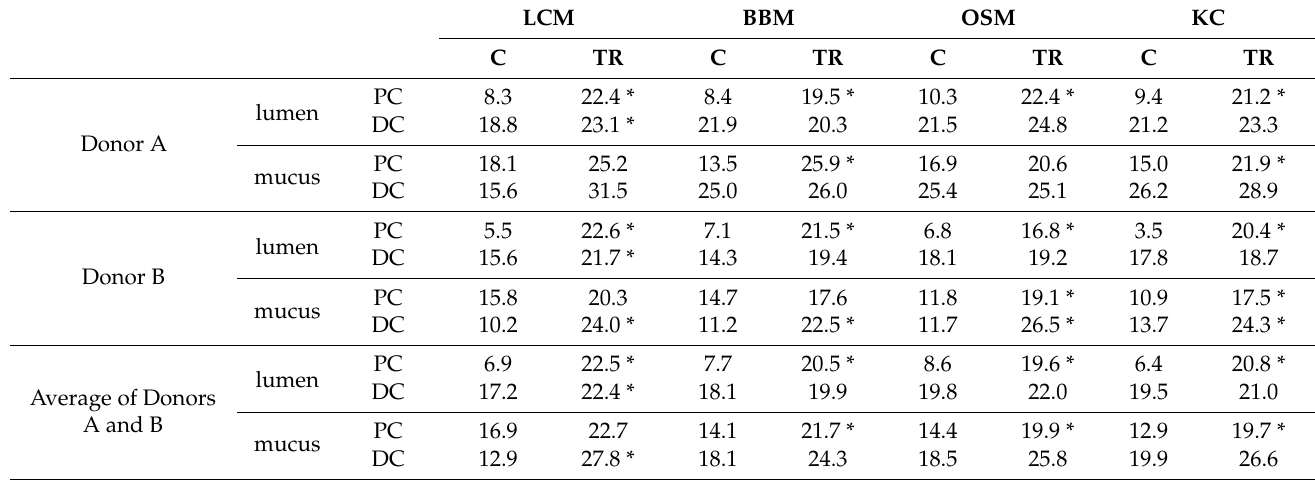
Table 1. Reciprocal Simpson diversity index in the lumen of the proximal colon at the end of the control and treatment periods. LCM